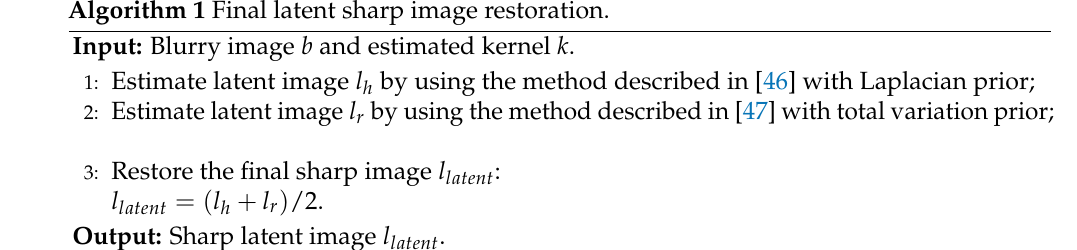
Algorithm 1 Final latent sharp image restoration.